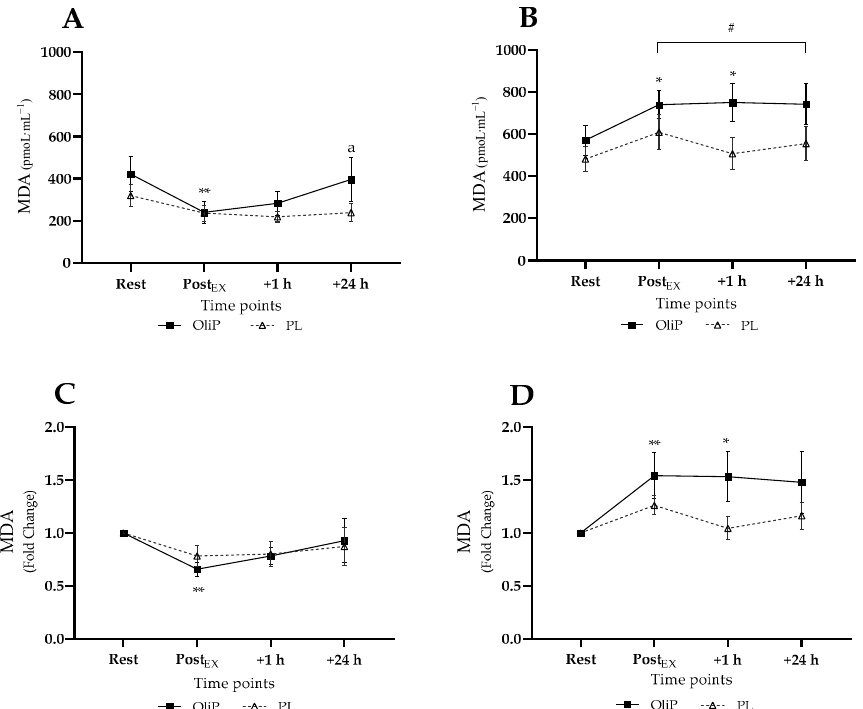
Figure 2. Plasma malondialdehyde (MDA) responses expressed in mean absolute (pmoL · mL − 1 ) and fold change terms in participants that were supplemented with OliPhenolia ® (OliP) for 16 consecutive days or with a matched placebo (PL). ( A , C ) Pre-intervention, before supplementation; ( B , D ) Post 16-day supplement intervention. * denotes difference within OliP compared with resting levels ( p ≤ 0.038); ** denotes difference within OliP compared to rest ( p ≤ 0.008); a indicates difference within trial compared with PostEX ( p = 0.05); # all significantly different to comparative timepoint pre-intervention within both PL and OliP ( p ≤